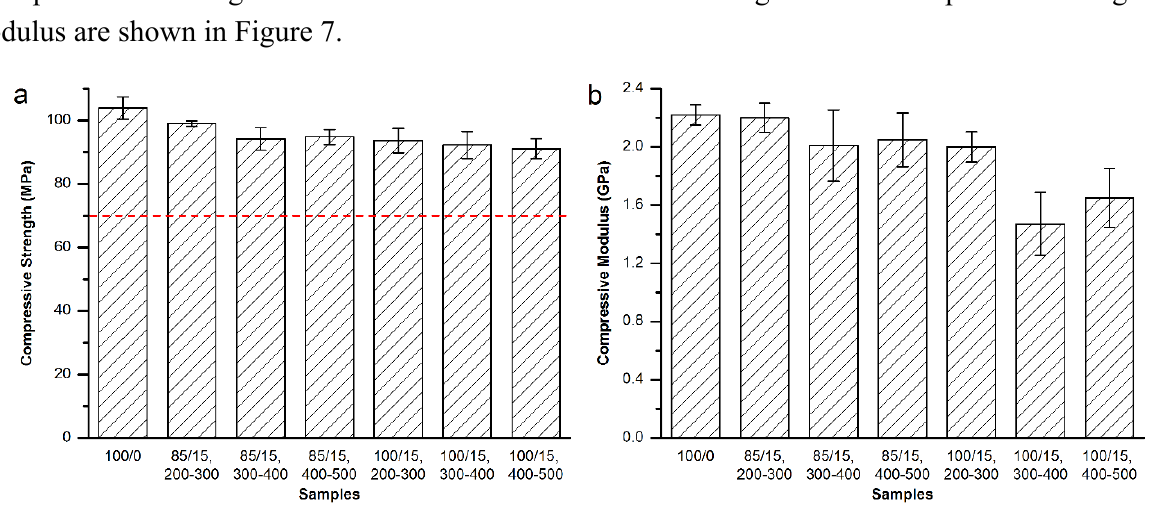
Figure 7. ( a ) Compressive strength and ( b ) compressive modulus of the MC modified Spineplex™ bone